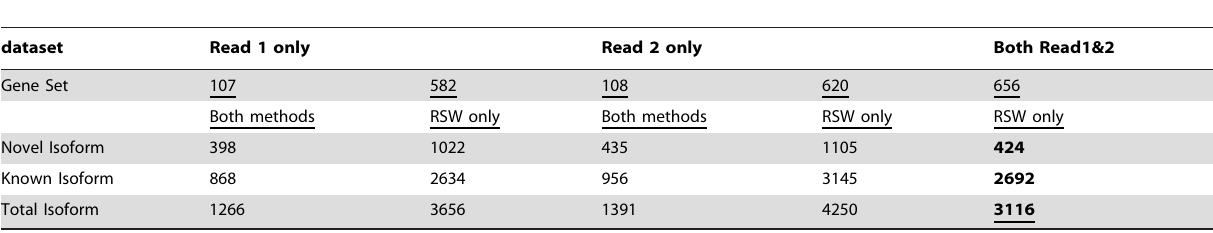
Table 4. Counts of spliced regions detected by RSW and proteomics from the SKBR3 cell line.